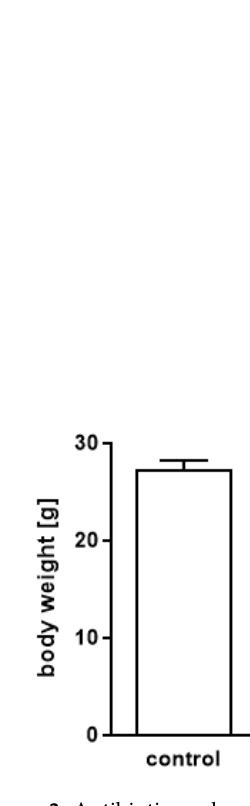
Figure 3. Antibiotics reduce blood sugar level of 5xFAD mice. ( A ) Body weight of the mice was measured after 14 weeks of the respective treatment. ( B ) Samples from truncal blood collected during sacrifice were used for quantification of blood sugar levels. Data are given as mean + SEM. Statistical analysis was performed by one-way ANOVA with Tukey’s post-test (*, p < 0.05).